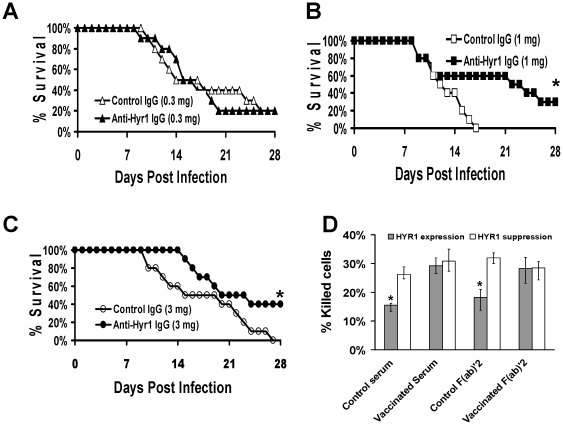
Dose dependent passive immunization with anti-Hyr1p IgG protected against murine hematogenously disseminated candidiasis.Mice were given 0.3 mg (A), 1 mg (B) and 3 mg (C) of anti-Hyr1p IgG by intraperitoneal injection 2 hr before infecting with 6.2×105 blastospores of Candida albicans 15563 via the tail vein. Survival of mice (n = 10 per group) was monitored twice daily. * P = .001 by log-rank test vs. mice receiving non-specific, rabbit control IgG. (D) Effect of vaccinated or control F(ab′) 2 on blocking HL-60 derived neutrophil killing of C. albicans. C. albicans overexpressing or suppressing Hyr1p were used in the assay to demonstrate specificity of the F(ab′) 2 fragments to Hyr1p. Control denotes assay performed either in the absence of F(ab′) 2 or in the presence of F(ab′)2 from non-specific, rabbit control IgG. Data are displayed as median ± interquartile range. * P = .001 by Mann-Whitney test.